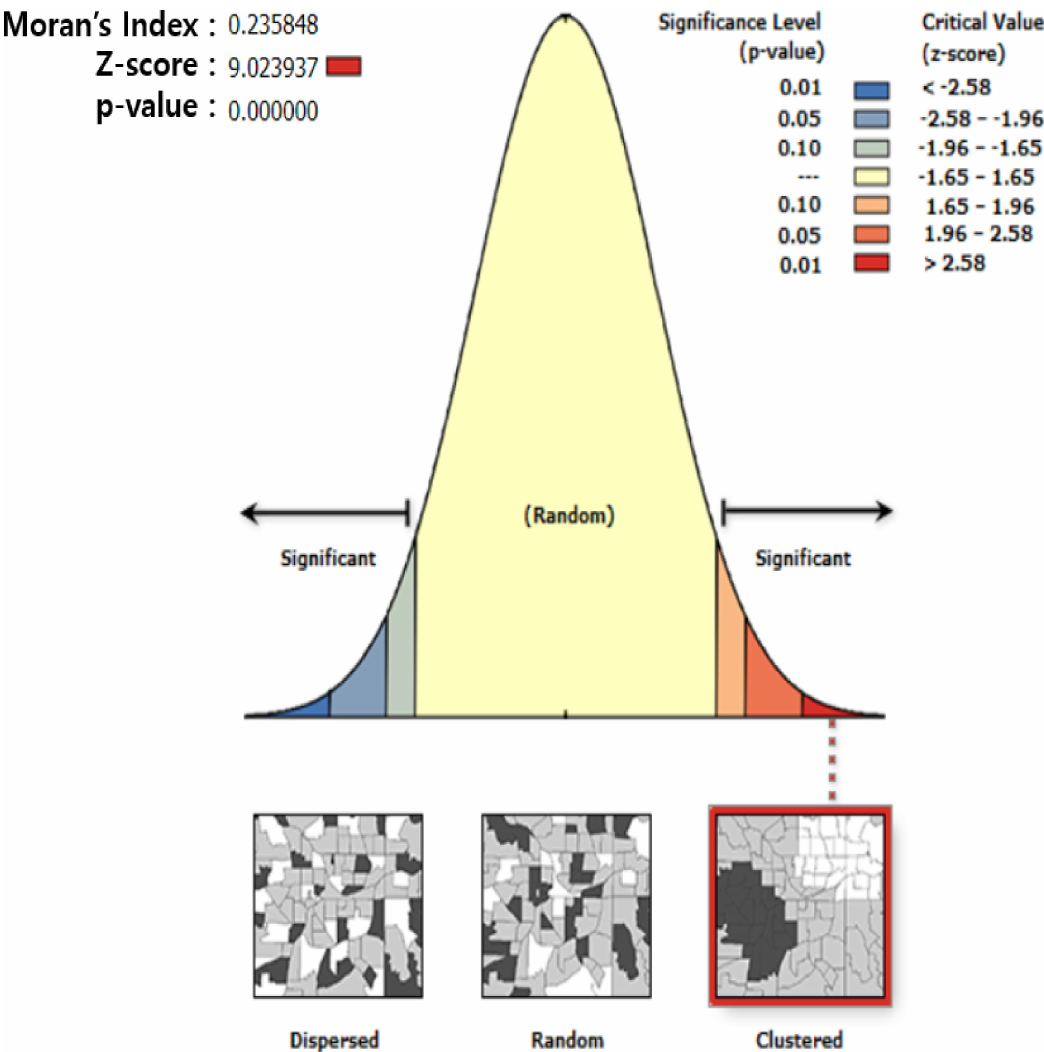
Fig. 2 Moran ’ s diagram for health screening participation rate di ff